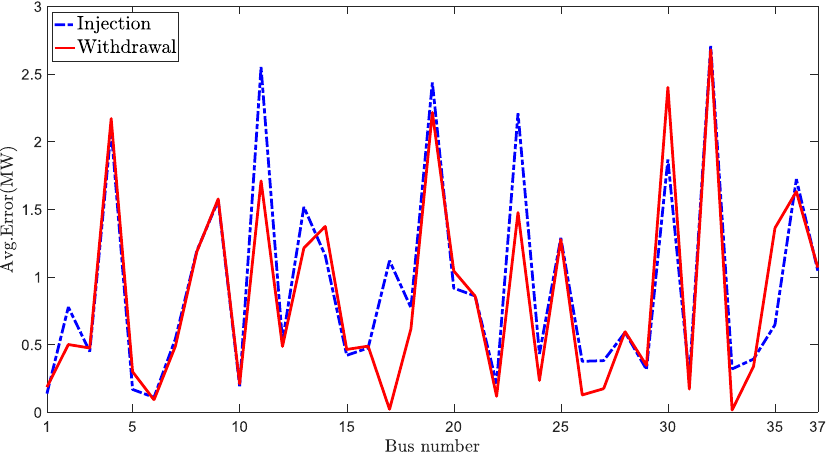
Figure 8. Average errors of transmission line power flows with 100 MW injection or withdrawal into each bus.